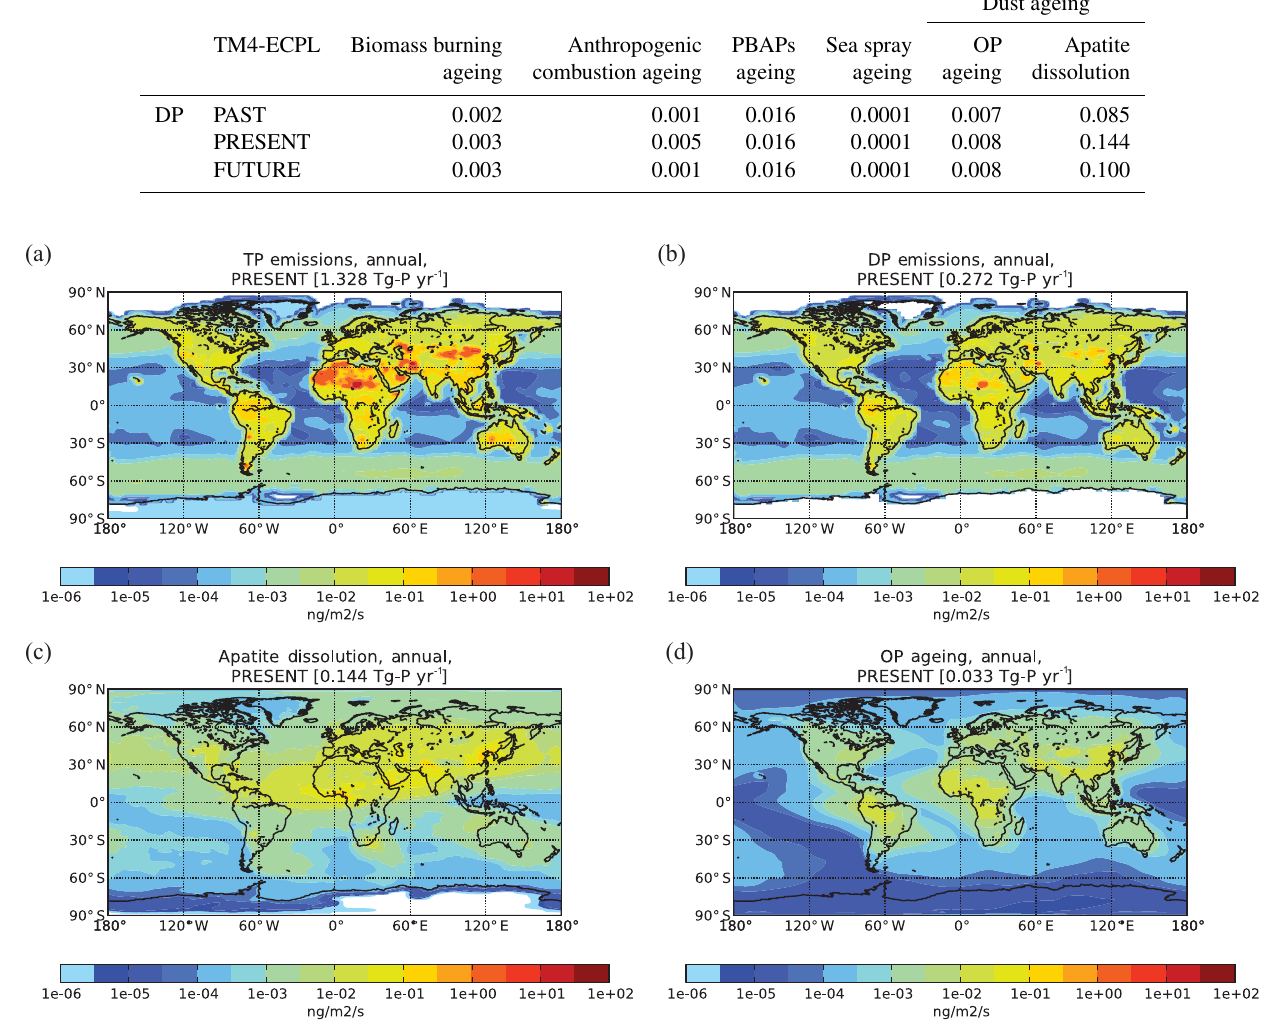
Figure 2. Annual averaged column distributions (in ng-Pm − 2 s − 1 ) of the (a) TP emissions, (b) DP emissions, (c) DIP flux from apatite dissolution and (d) DOP production due to OP atmospheric ageing, as calculated by the TM4-ECPL model for the present atmosphere (year